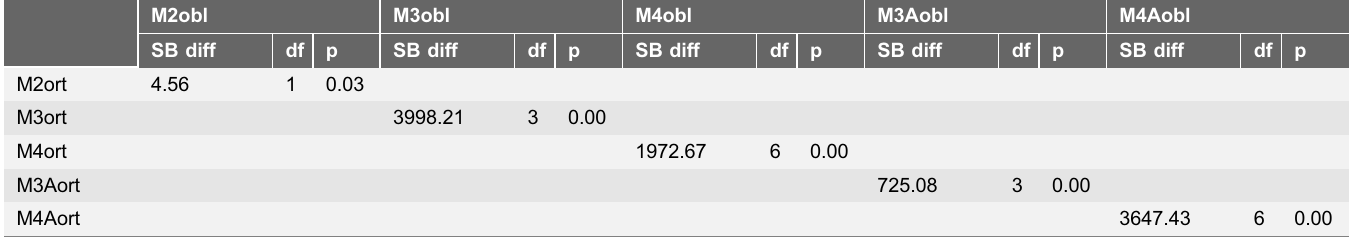
Table 5. Satorra-Bentler scaled chi-squared statistics for nested CFA